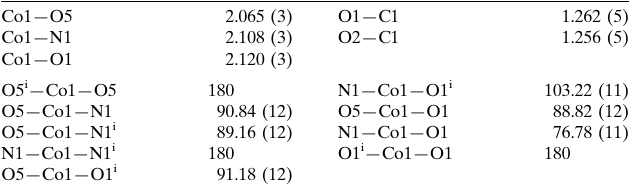
Selected geometric parameters (A˚ , (cid:3) ).